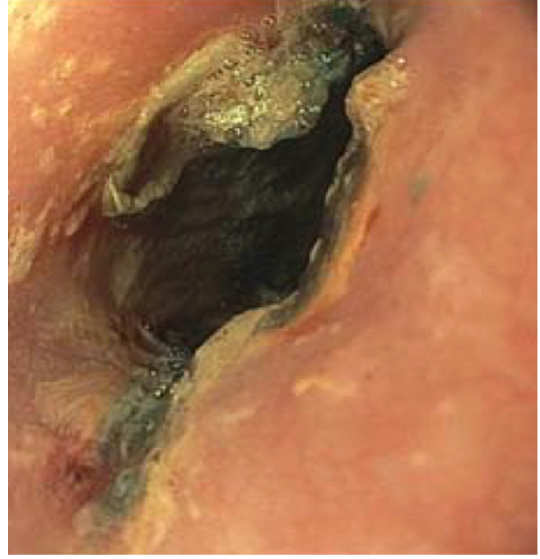
Figure 3. Endoscopy showing wall necrosis of the middle esophagus immediately following button battery removal.